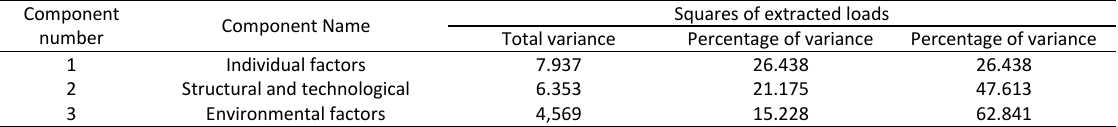
Table 2. The results of the variance share of each factor in the 3-factor model of organizational trauma questionnaire Component number